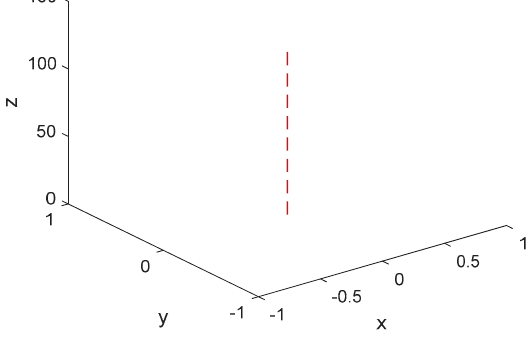
Algorithms 2018 , 11 , x FOR PEER REVIEW Figure 8. The estimation error of the quadrotor. Figure 8. The estimation error of the quadrotor. Figure 8. The estimation error of the quadrotor.